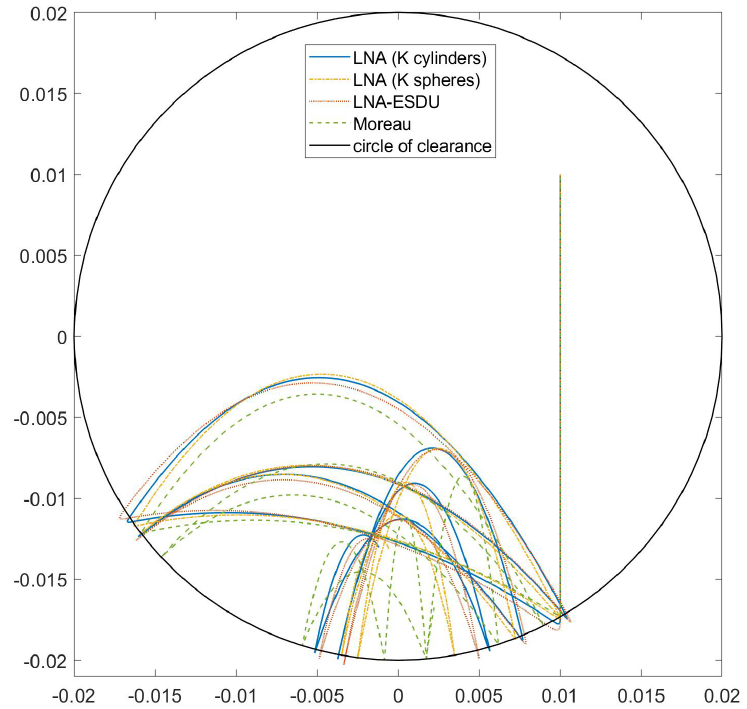
Figure 10. Trajectory of the body–center G 1 for the four models considering the asymmetrical impact. Starting point at q 0 = [ 0.01,0.01,0 ] T